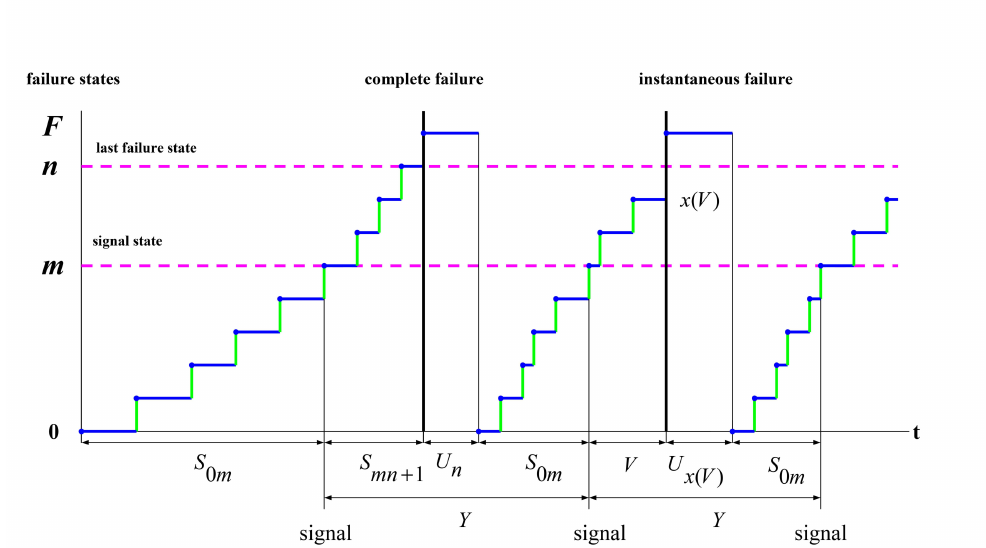
Figure 3. Realization of a degrading process under threshold policy ( m , n )